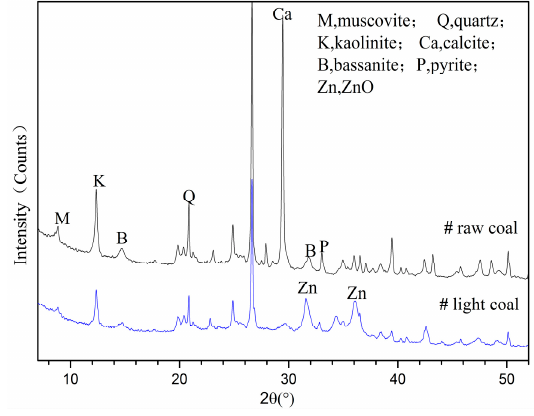
Figure 3. XRD patterns of LTA of SH raw and preheated SH light coal.